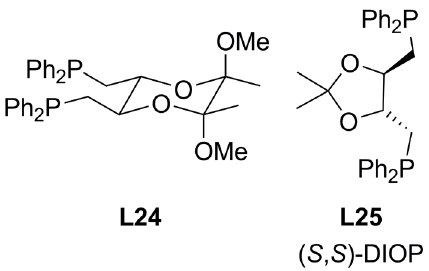
Figure 10. Berens’ DIOP analogue